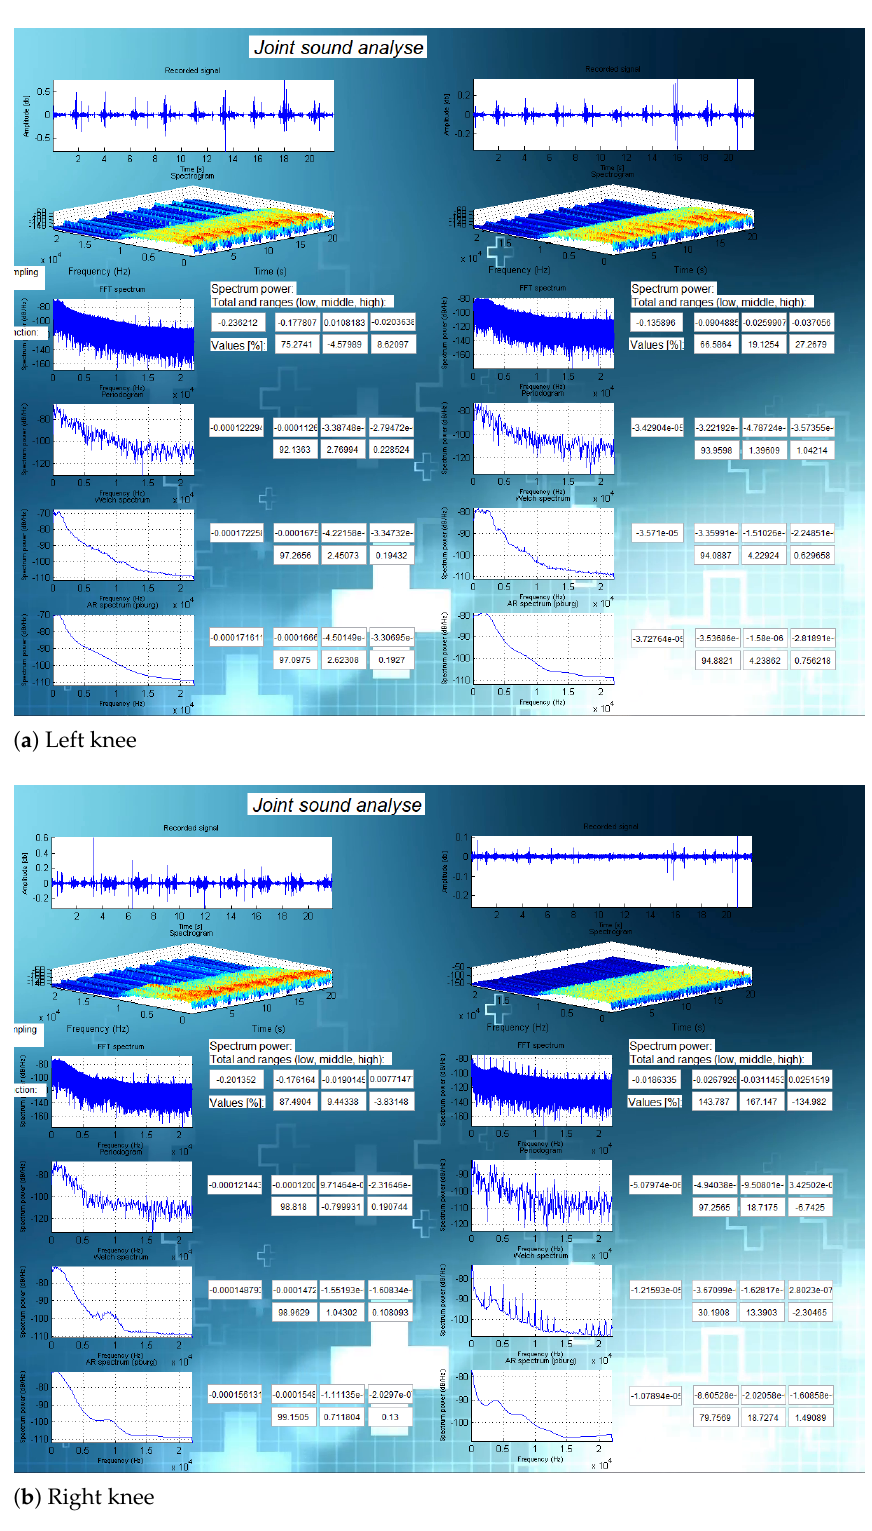
Figure 10. Analysis for a person after multiple knee injuries and surgeries (subject 14).